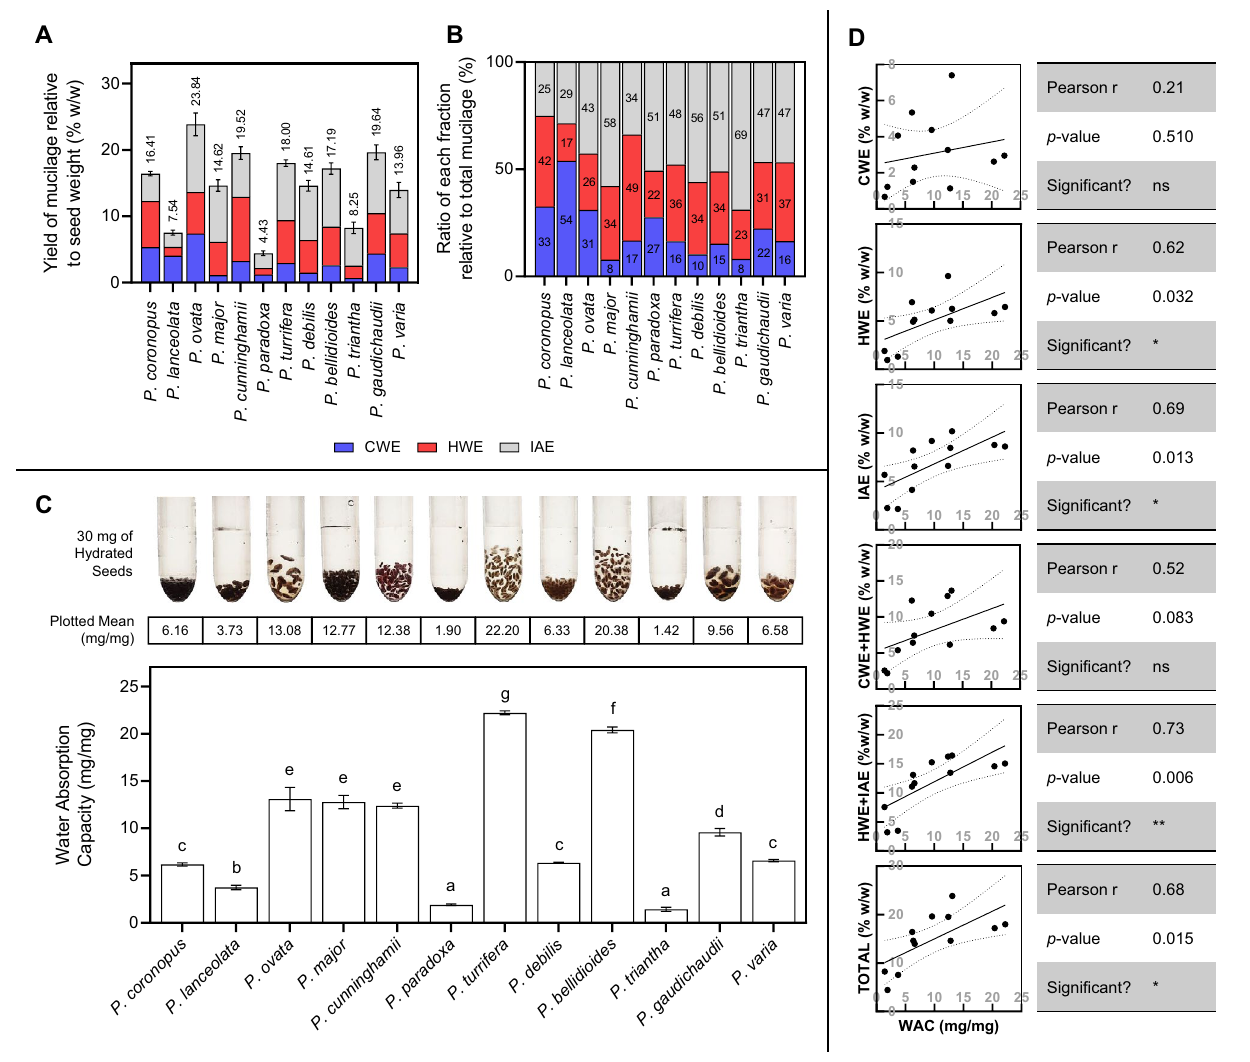
Figure 3. Seed mucilage yield, fractionation and water absorption traits of 12 Plantago species. ( A ) Yield of mucilage as a fraction of the whole seed. ( B ) Quantity of each isolated mucilage fraction as share of total mucilage. Values within bars are plotted values rounded to the nearest integer. CWE = cold water extractable (blue); HWE = hot water extractable (red); IAE = intense agitation extractable (grey). ( C ) Water absorption capacity of Plantago seeds. Above the plot are plotted mean values and a representative image of 30 mg of hydrated and swollen Plantago seeds. Samples sharing a letter are not significantly different from each other ( p > 0.05). ( D ) Study of correlations between water absorption capacity (WAC) and mucilage yield/fractionation traits (seed-relative traits from A ). Linear models plotted with 95% confidence bands. ns = not significant. Values presented are means of five replicates in ( A ) and ( B ) and three replicates in ( C ) Error bars correspond to one standard